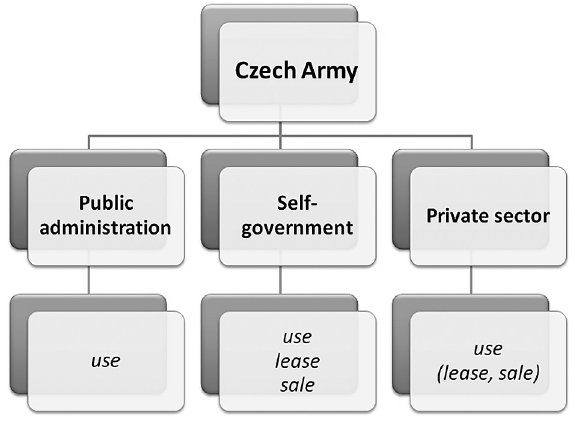
Fig. 1. Diagram of changes of the owners of post-military buildings and areas Source: authors’ own